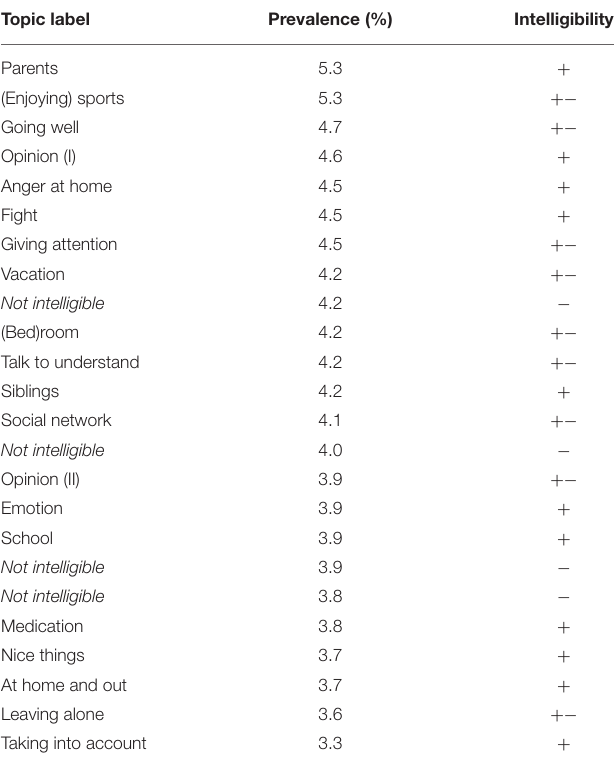
TABLE 5 | List of calculated LDA topics along with their prevalence and intelligibility. Topic